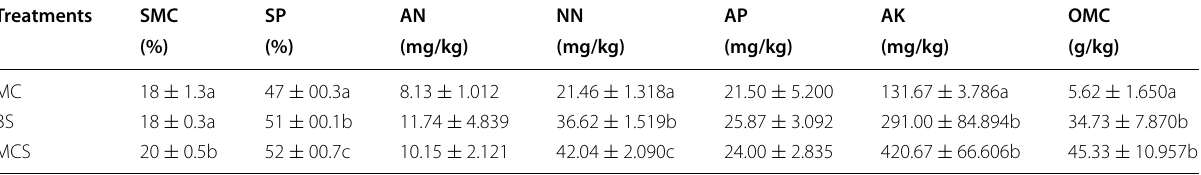
Different lowercase letters in the same column indicate a significant difference at the 0.05 level. MC, BS, and MCS represent the biochar addition amount of 0 t/m 3 , 10 t/m 3 , and 20 t/m 3 respectively SMC soil moisture content, SP soil porosity, AN ammonium nitrogen, NN nitrate nitrogen, AP available phosphorus, AK available K, OMC organic matter content